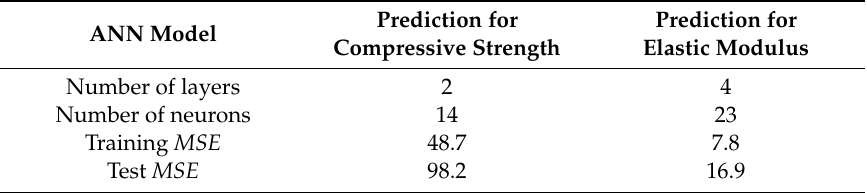
Figure 3. ANN performance evaluation: ( a ) training, ( c ) test, and ( e ) training time for compressive strength and ( b ) training, ( d ) test, and ( f ) training time for elastic modulus analyses. Table 4. Optimal architecture and prediction accuracy of the ANN model.